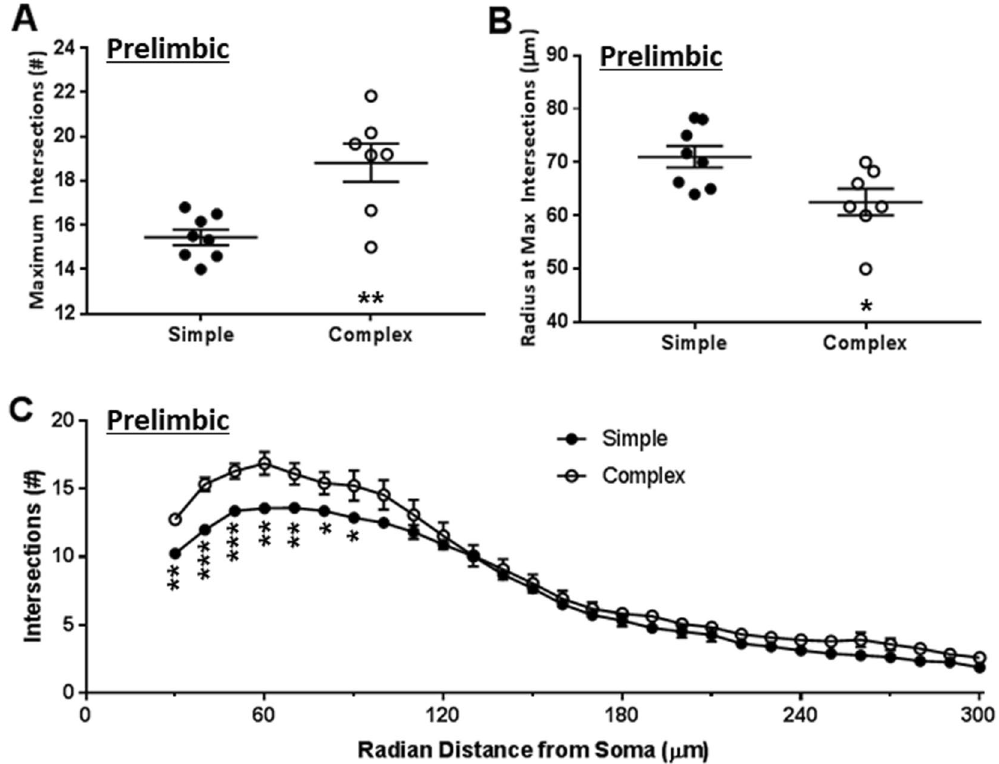
Figure 4. Complex environment caused dendritic expansion proximal to the cell soma. A grid of concentric circles was placed on neurons centered on cell soma (incremental radius = 10 µ m). Intersections with successive circles in the grid were counted. Panel A depicts maxima for the number of the intersections. Panel B depicts radius of the circle where maximum radius was encountered. Panel C depicts number of intersections (ordinate) as a function of radial distance from soma (abscissa). ** p < 0.05; ** p < 0.01; and *** p < 0.001; unpaired Student’s t-test. n = 8 animals for simple and 7 for complex